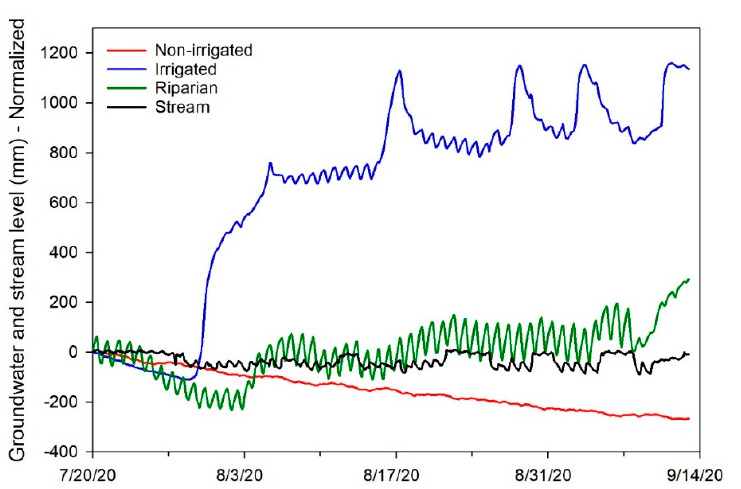
Figure 4. Stream and shallow groundwater level variability in wells at riparian, irrigated, and non-irrigated field locations during the 2020 irrigation season (27 July to 12 September).